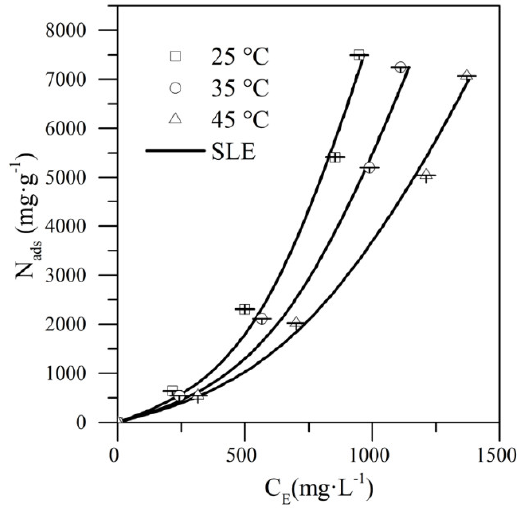
Figure 6. Adsorption isotherms for CTAB onto M11 nanoparticles at a fixed concentration of nanoparticles (1200 mg·L −1 ) varying the CTAB dosage below its critical micelle concentration (CMC) at 25, 35, and 45 °C using the solid–liquid equilibrium (SLE) model. C E (mg·L −1 ) is the asphaltene equilibrium concentration and N ads (mg·g −1 ) is the adsorbed amount.